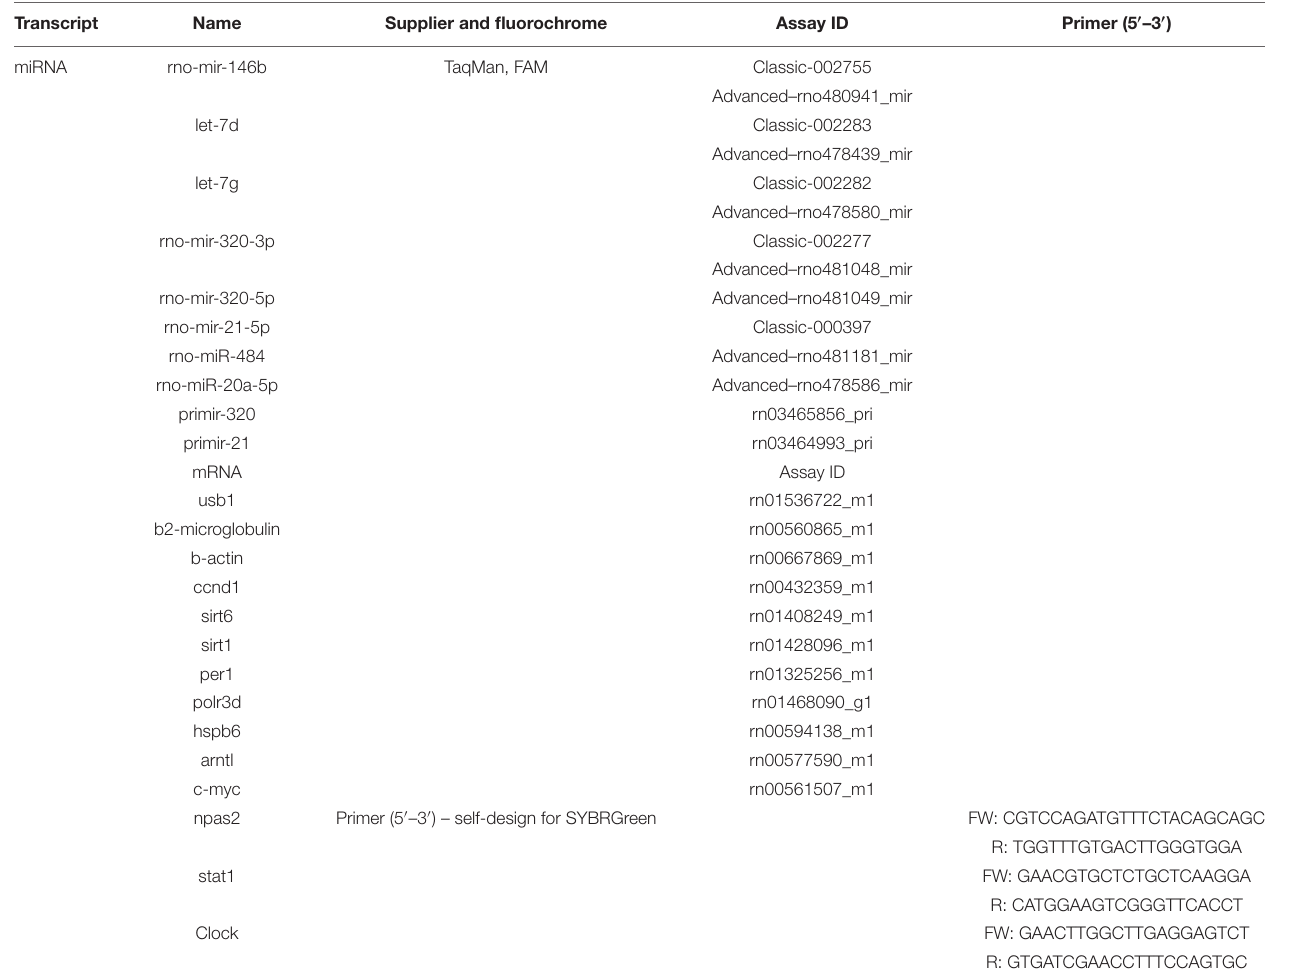
TABLE 1 | List of probes purchased from TaqMan or self-designed for